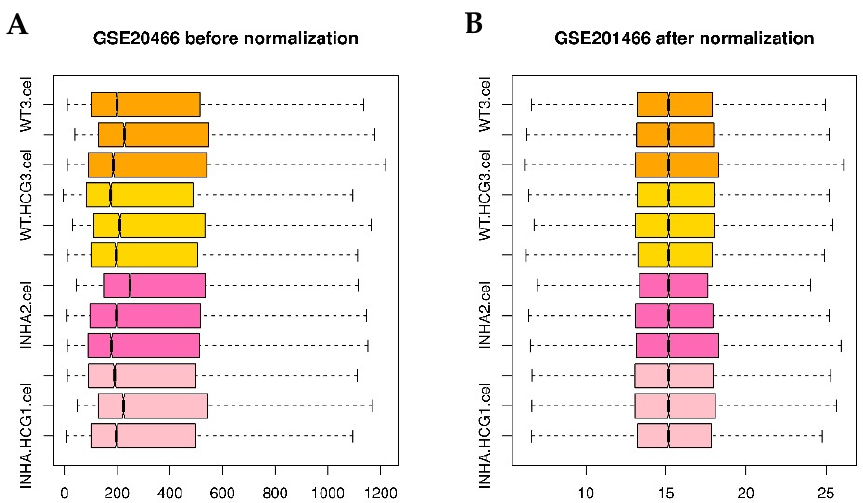
Figure 10. Boxplot of GSE20466 data preprocessing before ( A ) and after normalization ( B ). Pink, hot pink, gold, and orange boxes refer to Inha − / − (hCG), Inha − / − , WT(hCG), and WT samples.